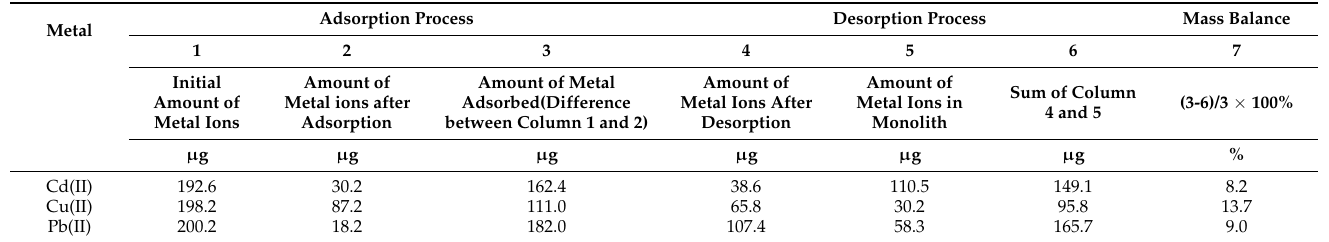
Table 6. Mass balance of adsorption and desorption processes (GS 2:1, [Cu] 0 = 9.61